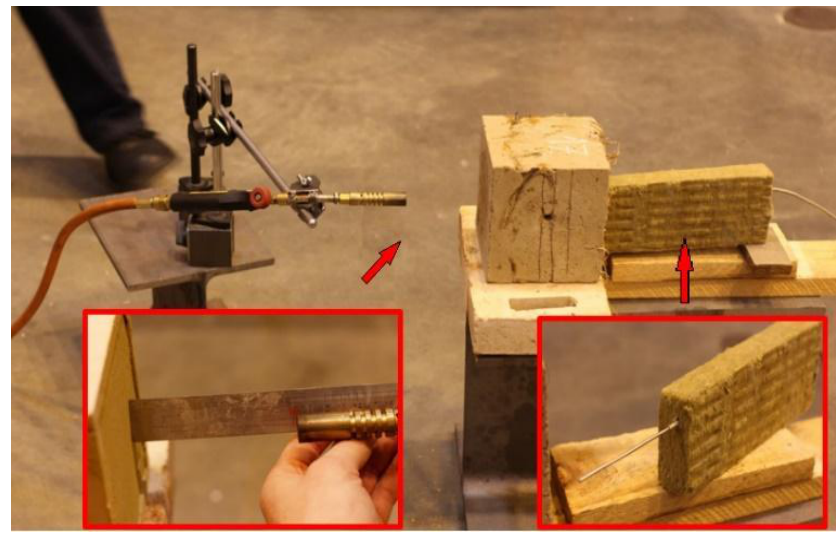
Figure 4. A test rig with a torch stably fixed at a 10 cm distance and a thermocouple inside the sample tested.